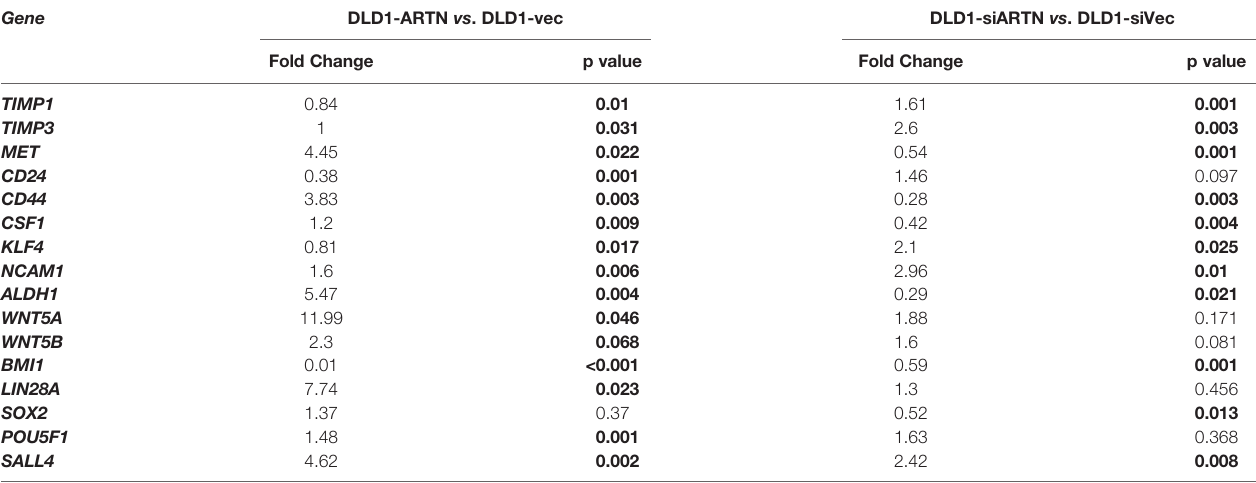
TABLE 5 | Real time-PCR analysis for mRNA expression of CSC markers in DLD1 cells with either forced or depleted expression of ARTN. Gene